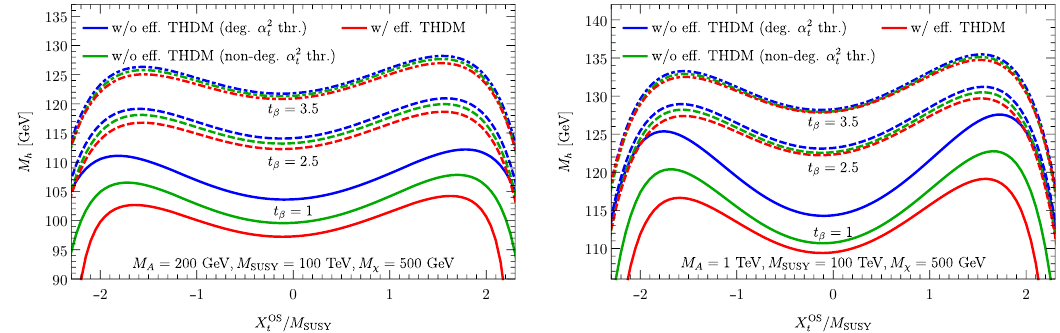
Figure 6 . M h as a function of X OS =M SUSY for tan (cid:12) = 1 (solid), tan (cid:12) = 2 : 5 (dashed), and t tan (cid:12) = 3 : 5 (dotdashed). Left: M A = 200 GeV. Right: M A = 1 TeV. The results of FeynHiggs without e(cid:11)ective THDM | using the degenerate O ( (cid:11) 2 ) threshold correction (blue) and using the t non-degenerate O ( (cid:11) 2 ) threshold correction (green) | are compared with the results of FeynHiggs t with e(cid:11)ective THDM